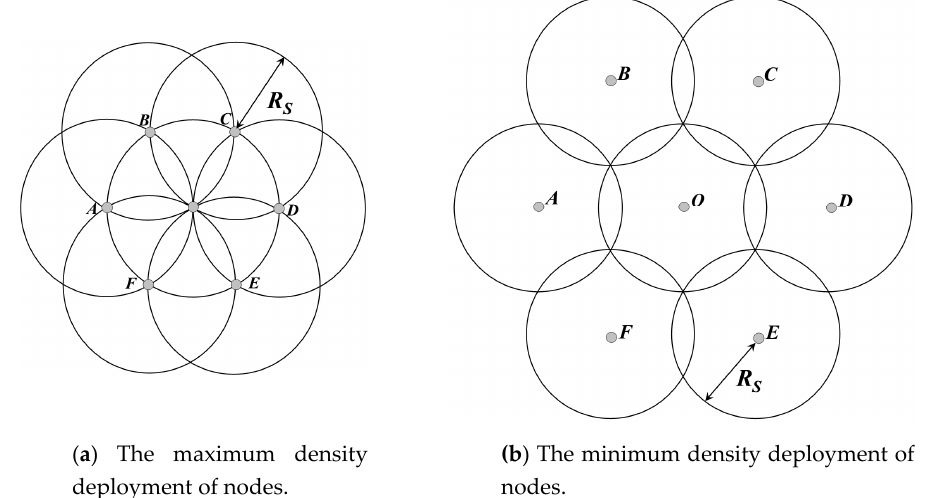
Figure 5. The maximum and minimum density deployment of nodes.